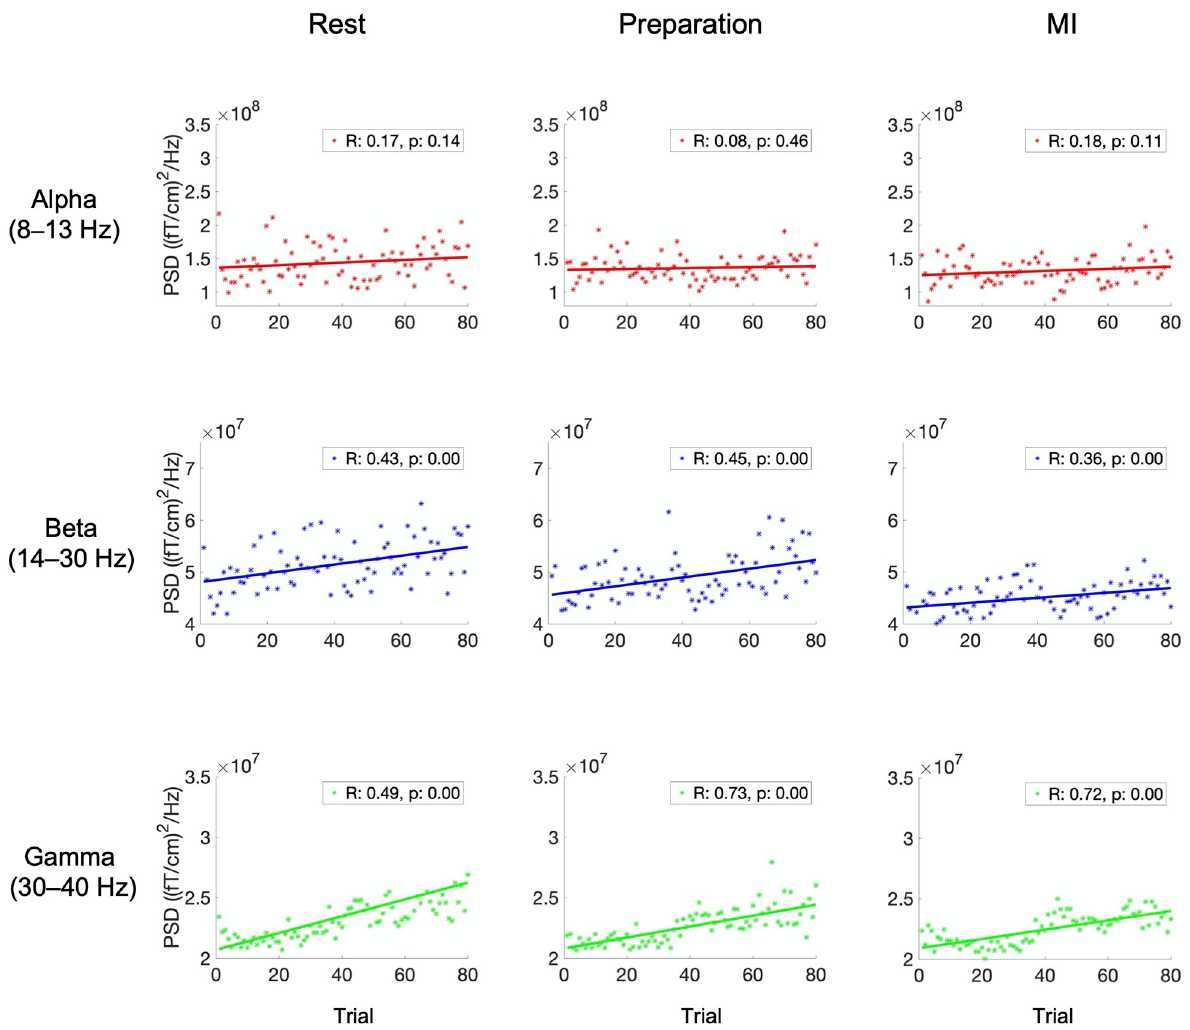
Fig 2. Alpha, beta, and gamma power over trials in Data 1. Power of alpha-, beta-, and gamma-band oscillations, averaged over all subjects and gradiometers, as a function of trial index when delivering visual feedback (Data 1). Correlation coefficient R and the corresponding p -value are shown in each